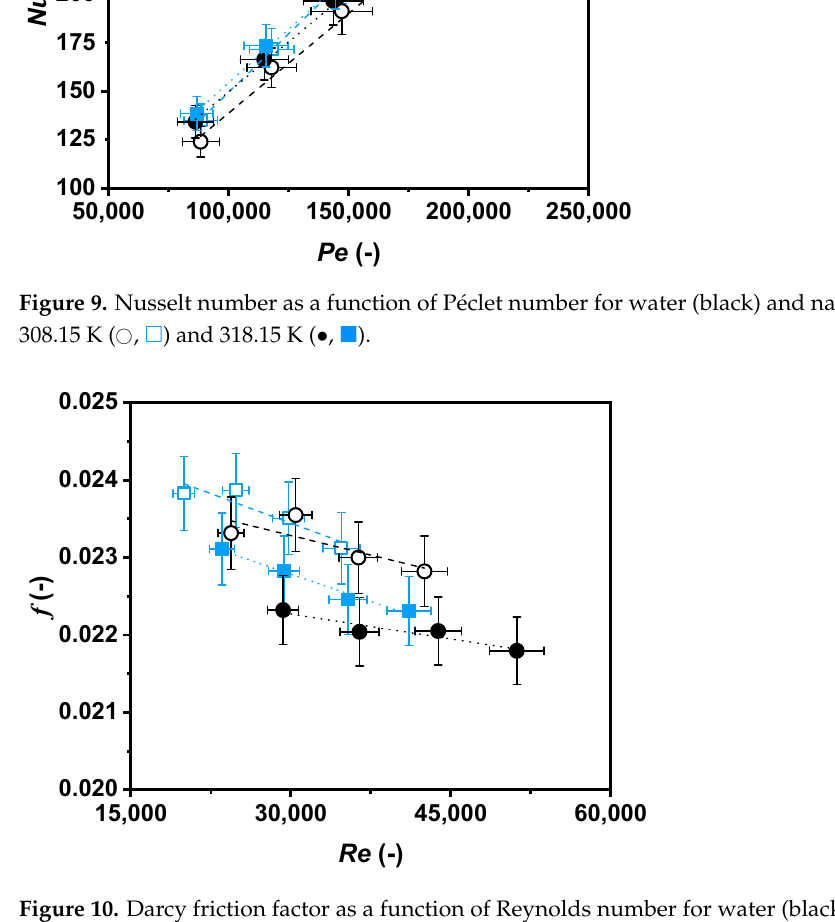
Figure 10. Darcy friction factor as a function of Reynolds number for water (black) and nanofluid (blue) at 308.15 K ( ○ , □ ) and 318.15 K ( ● , ■ ).